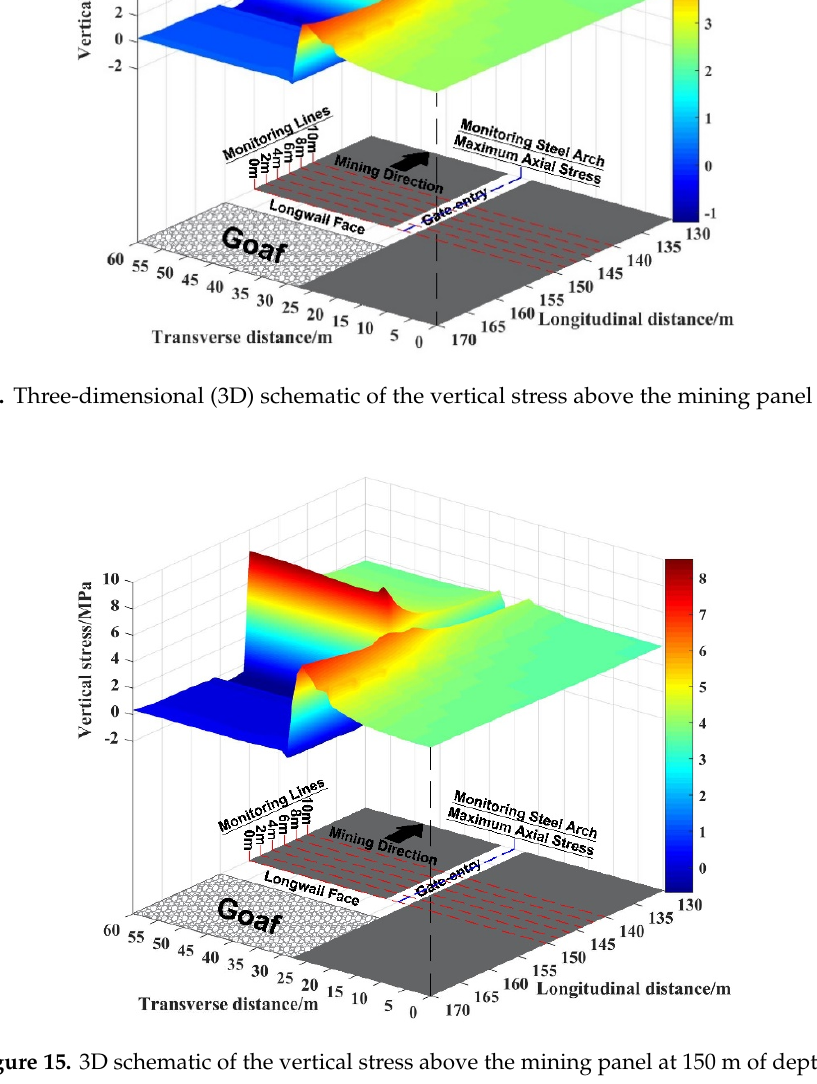
Figure 15. 3D schematic of the vertical stress above the mining panel at 150 m of depth.